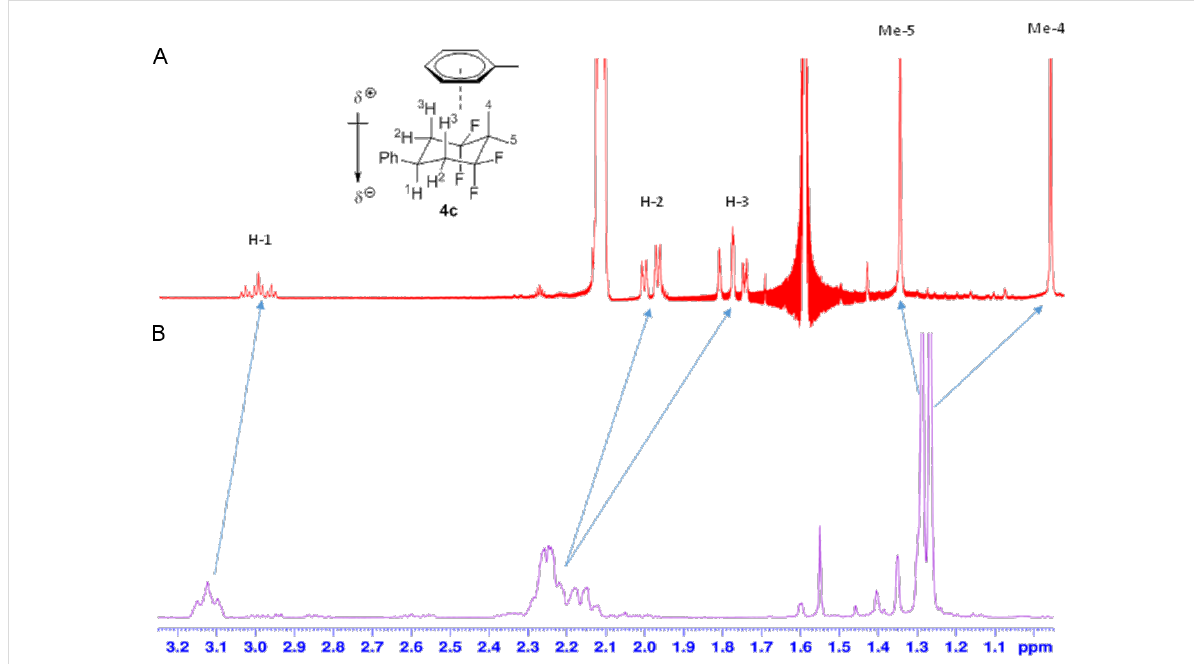
Figure 3: 1 H NMR spectra of 4c . A) shows the spectrum in [ 2 H 8 ]-toluene, and B) shows the spectrum in chloroform (CDCl 3 ). There are significant upfield-shifted proton signals in toluene, consistent with an electrostatic interaction between toluene and the electropositive hydrogen face of 1,1,3,3- tetrafluorocyclohexyl 4c .